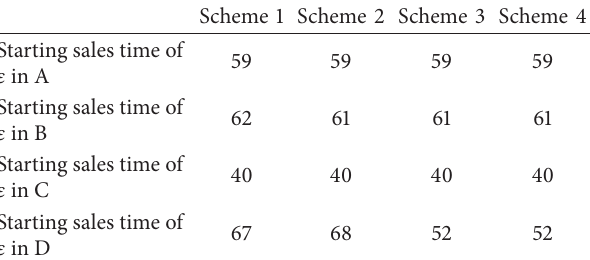
Figure 9: Total freight volume in different schemes. Figure 10: Total freight cost in different schemes. Table 15: Starting sales times of the finished product in different